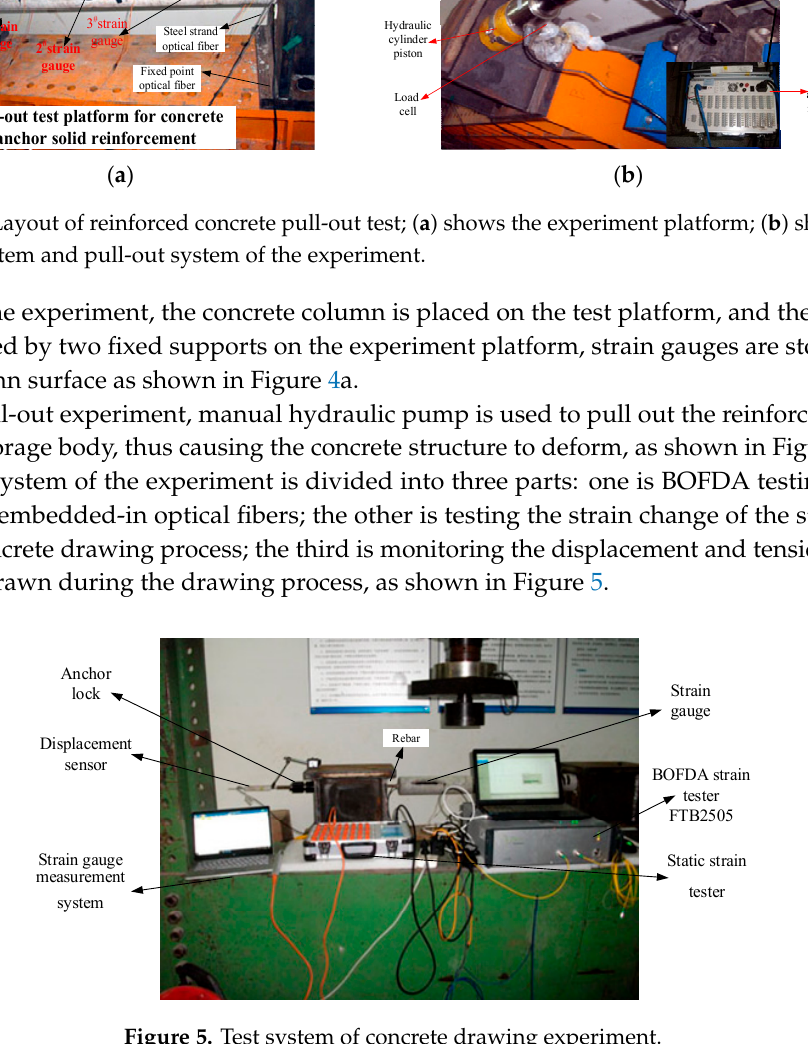
Figure 5. Test system of concrete drawing experiment.